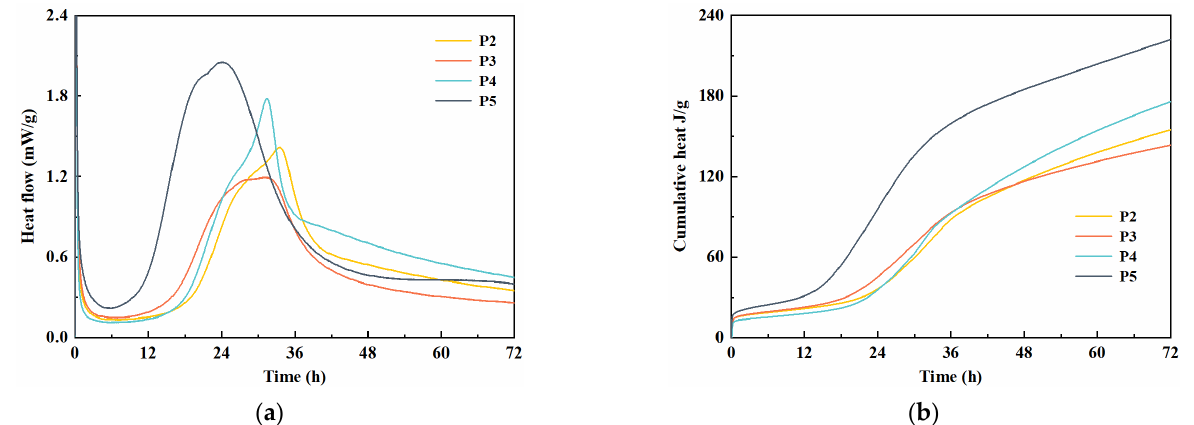
Figure 3. Heat release of binder pastes within 72 h. ( a ) rate of heat evolution; ( b ) cumulative hydration heat.